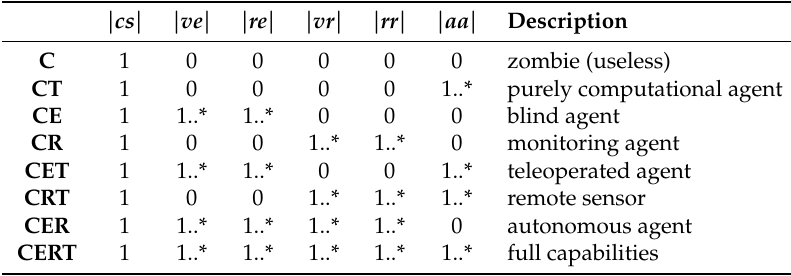
Table 2. Type of Agent, number of its Subsystems ( | ve | , | re | , | vr | , | rr | ) and number of inter agent communication Links ( | aa | ) expressed with respect to the number of Buffers of the considered Agent. | cs | | ve | | re | | vr | | rr | | aa |